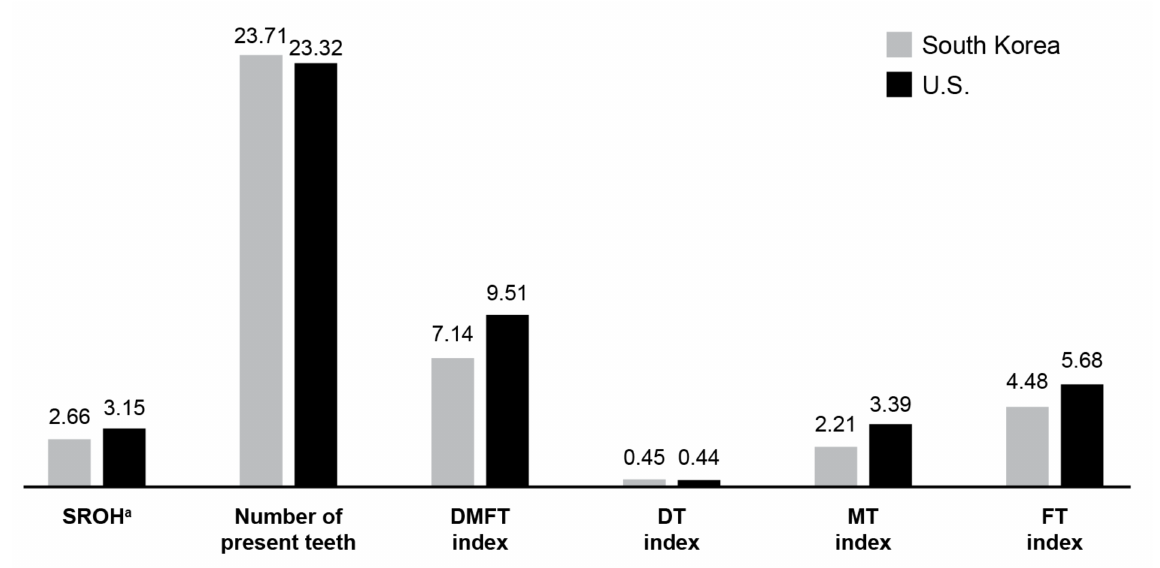
Figure 2. Oral health factors in Korean and American adults. a : Self-rated oral health (SROH) was surveyed using a 5-point Likert